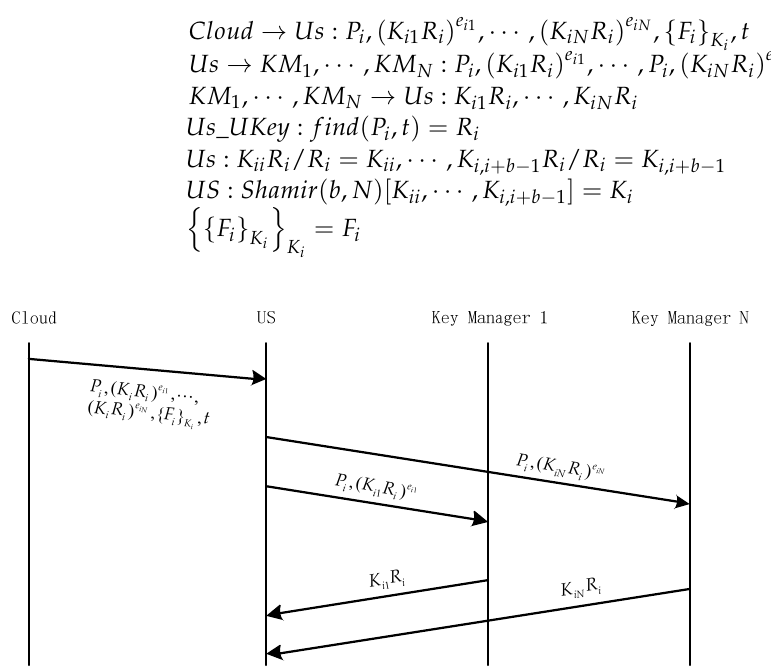
Figure 9. ADSS multi-KM file download.